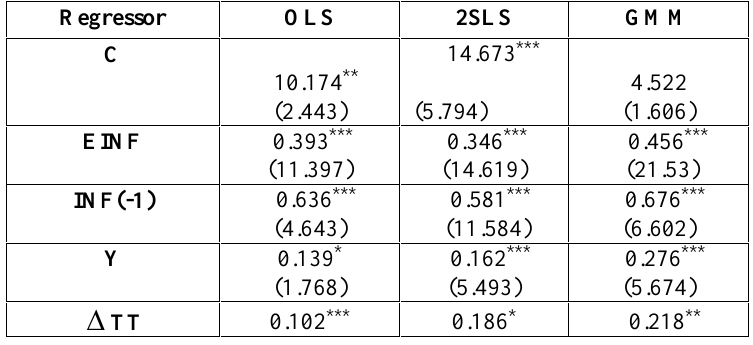
Table 7: Reduced Form Estimates of the Open Economy